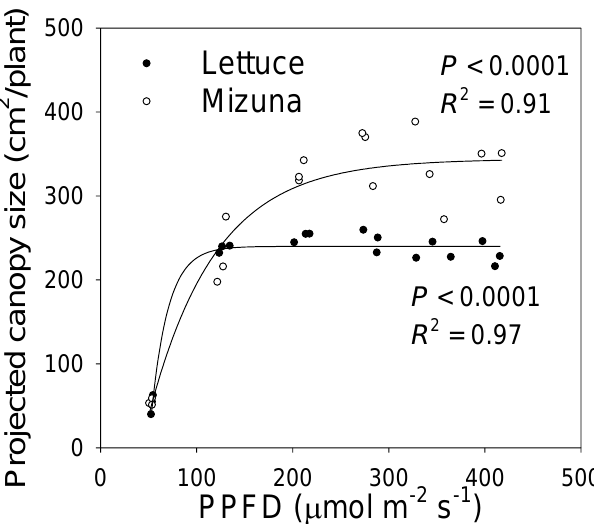
Figure 2. The projected canopy size (PCS) of mizuna ( Brassica rapa var. japonica ) and lettuce ( Lactuca sativa ‘Green Salad Bowl’) plants grown at six different photosynthetic photon flux densities (PPFDs). Data were collected at the end of the growing cycle (27 and 28 days for mizuna and lettuce, respectively). Each data point represents the mean of nine plants.